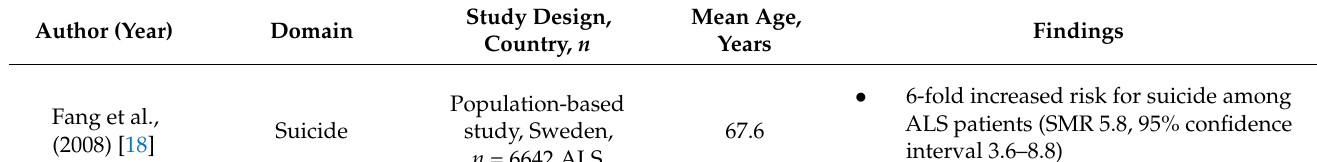
Table 2. Population-based studies of non-motor features in amyotrophic lateral